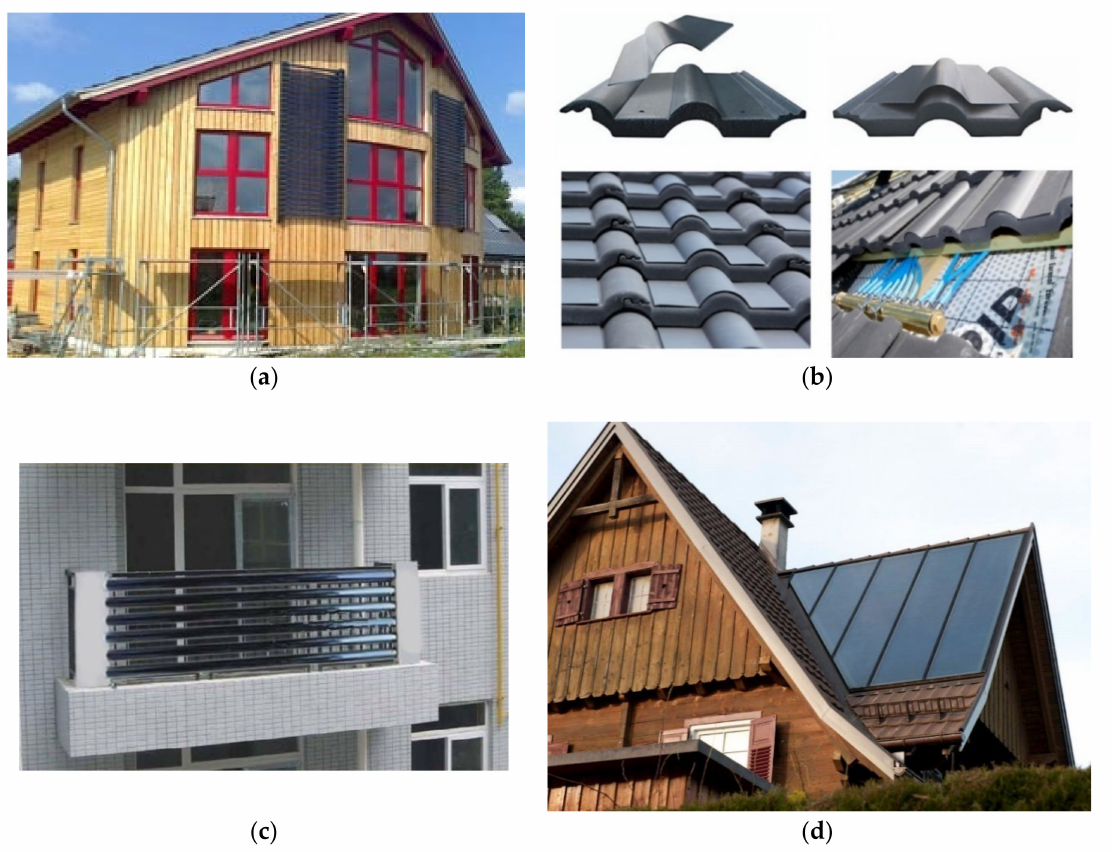
Figure 1. Example of customization of solar collector: ( a ) shortened tubes on the façade ( b ) collectors on roof tiles, ( c ) balcony solar water heater (Hurras ® ), and ( d ) specially made glazed collectors on roof (Domasolar ®